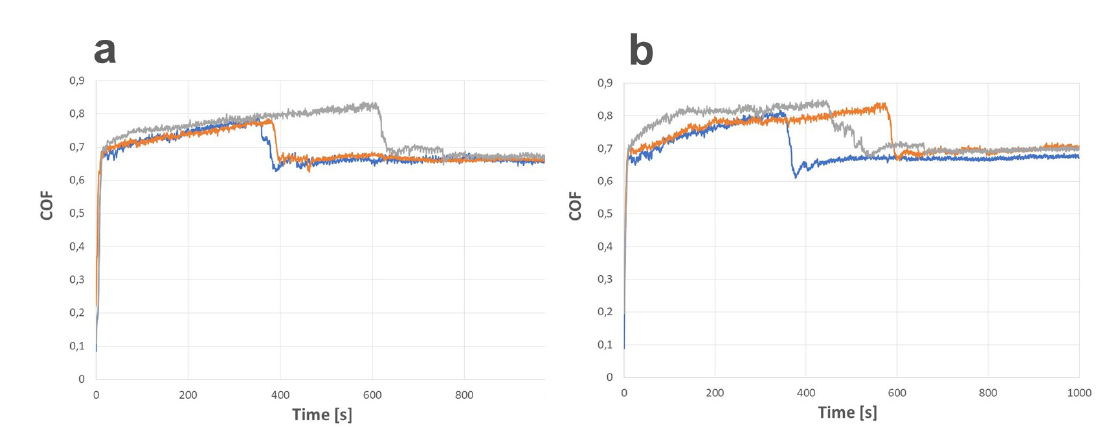
Figure 3. Coefficient of friction in dependence on the time of the test for a) APS and b) TWAS sprayed coatings